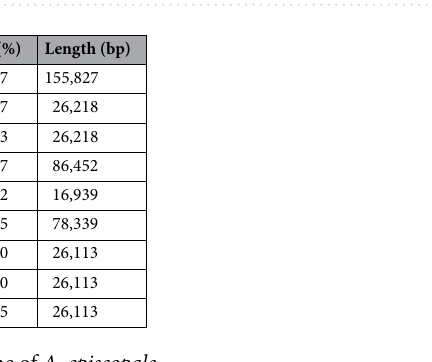
Table 3. Analysis of the base composition of the genome of A. episcopale